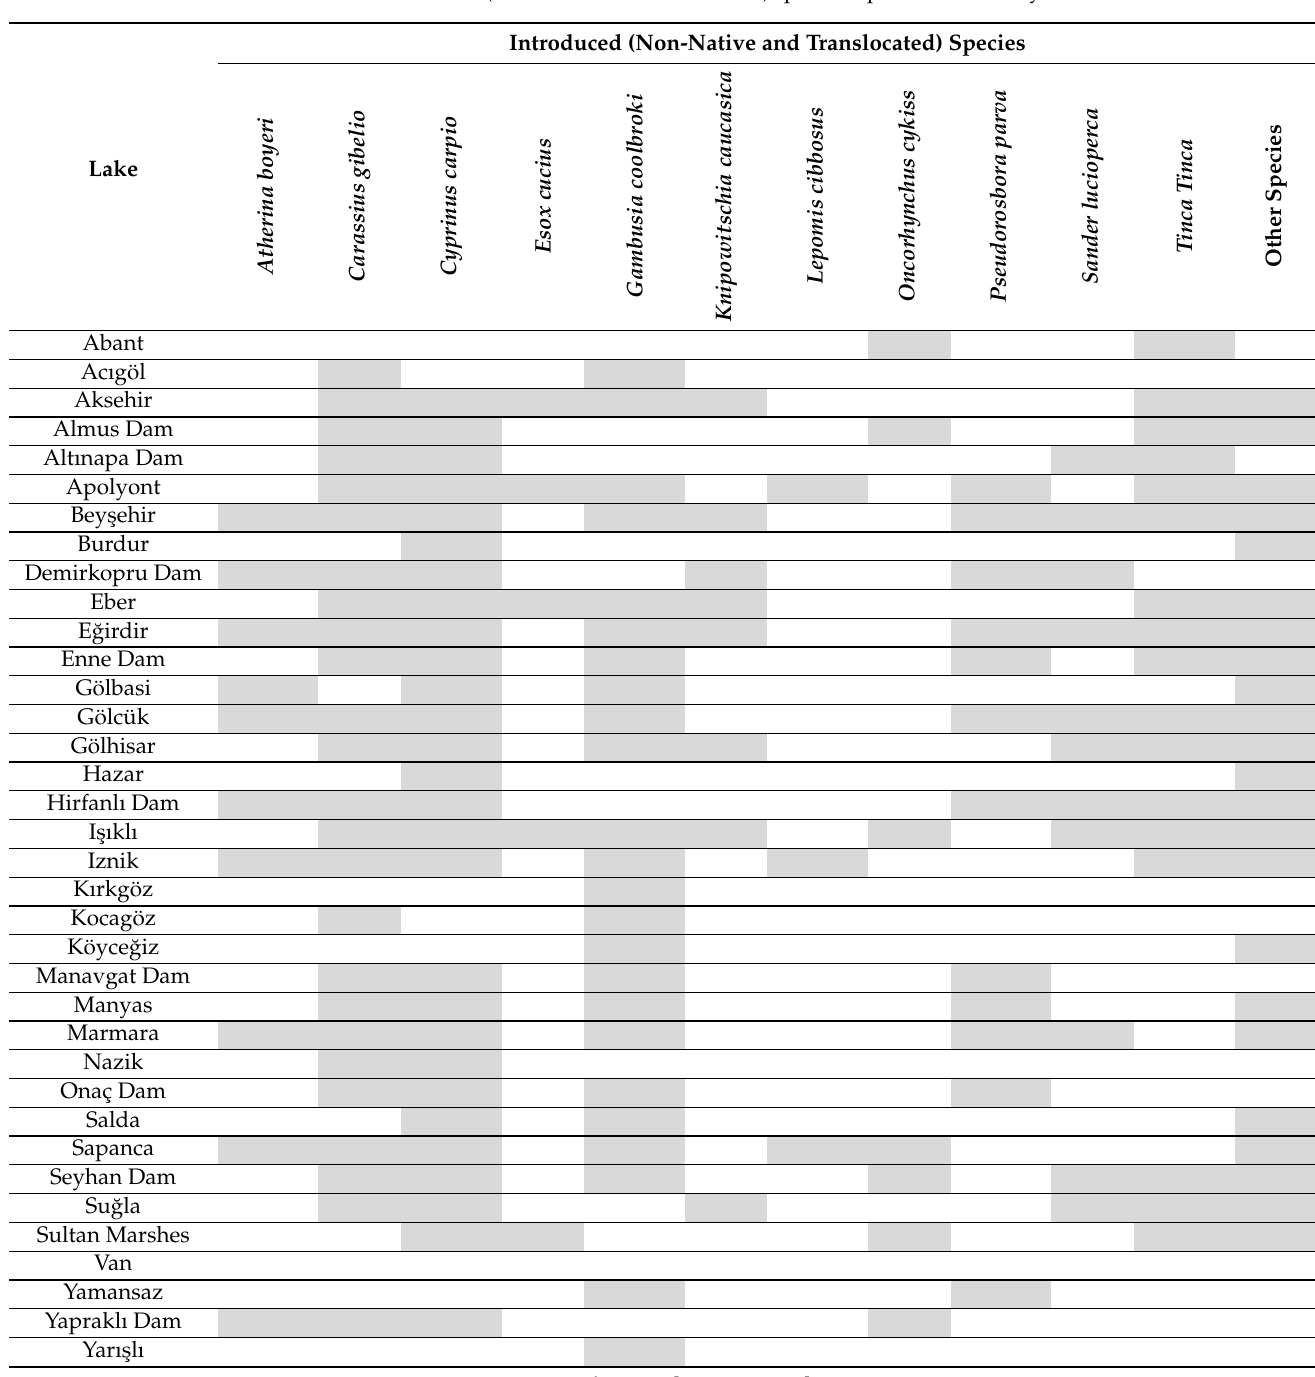
Table 4. Occurrence of the main introduced (non-native and translocated) species reported * in Turkey in the examined lakes. Introduced (Non-Native and Translocated)